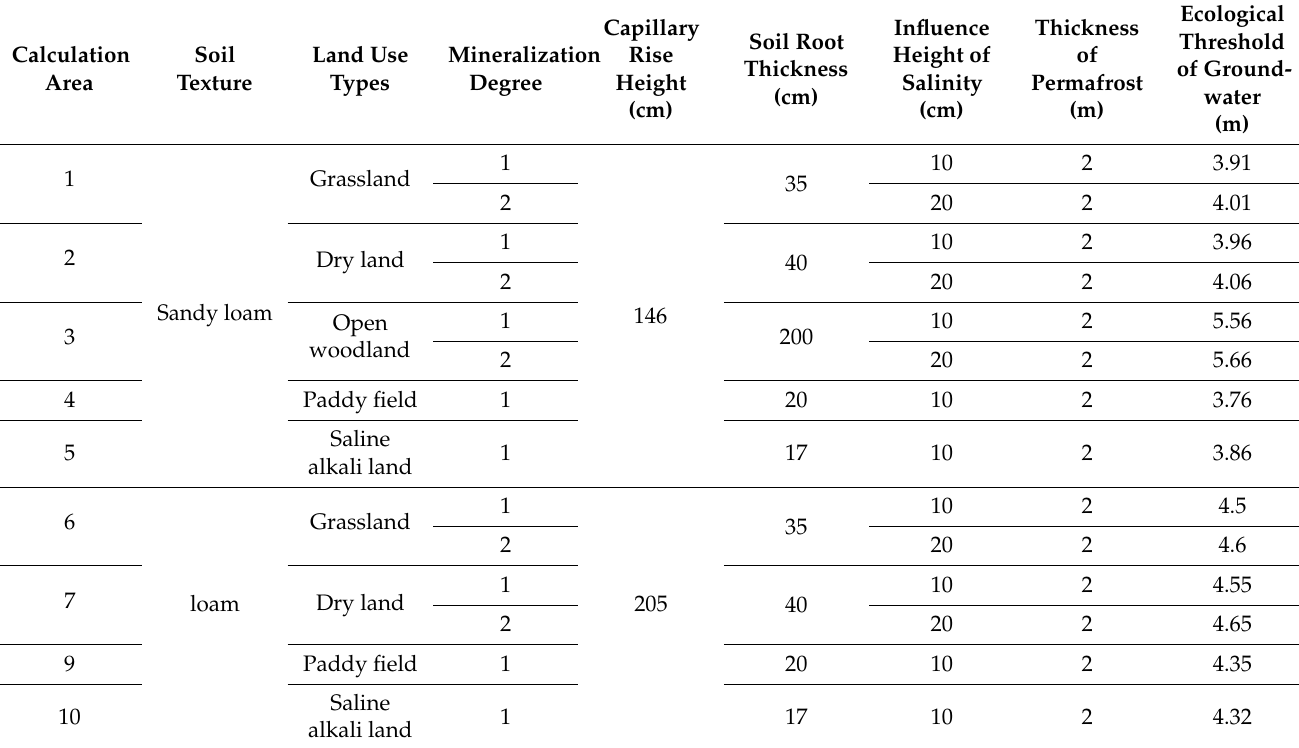
Table 4. Calculation of ecological threshold of groundwater